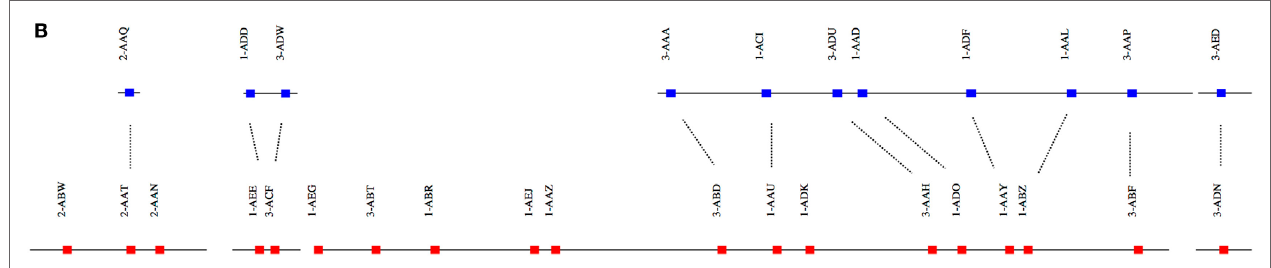
FigUre 2 | (a) Schematic representation of the rhesus macaque IGK locus. A schematic representation of the rhesus IGK locus (plus strand). The order of the scaffolds was determined by ordering the rhesus macaque IGK scaffolds against the African Green Monkey IGK locus. The functional and non-functional genes are represented in red and magenta blocks, respectively. The J cluster and C–K gene are represented in blue and yellow blocks, respectively. (B) Copy number variants observed between the main (red) and “sister” (blue) IGK scaffolds in the rhesus macaque. The dots in the figure indicate the correspondence of the “sister” genes and the main scaffolds in